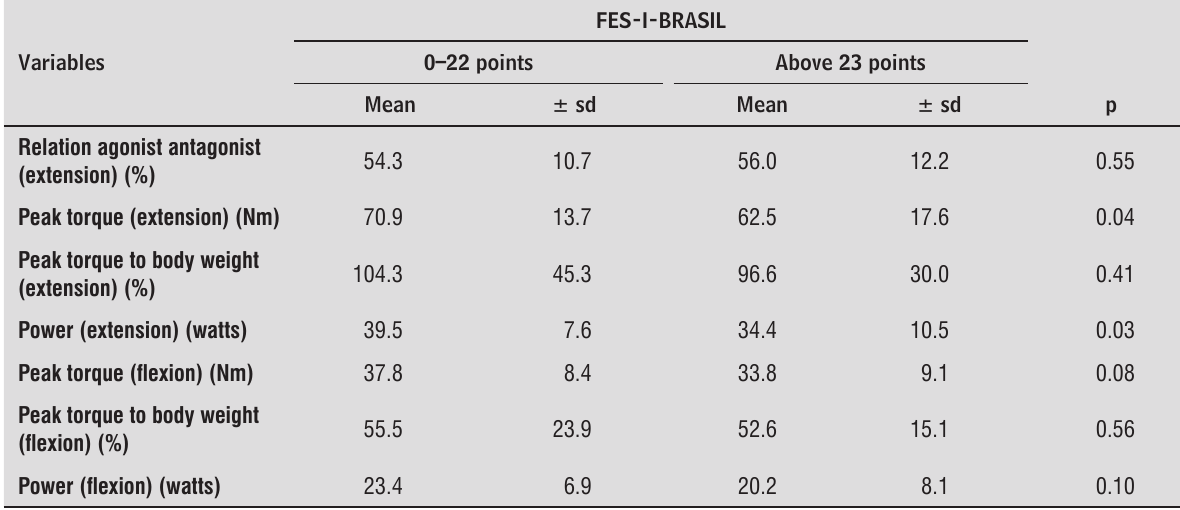
Table 4 - Mean and standard deviation (± sd) of the variables of the isokinetic dynamometry according to the self-effica- cy of falls Community-dwelling elderly women of Natal, RN,